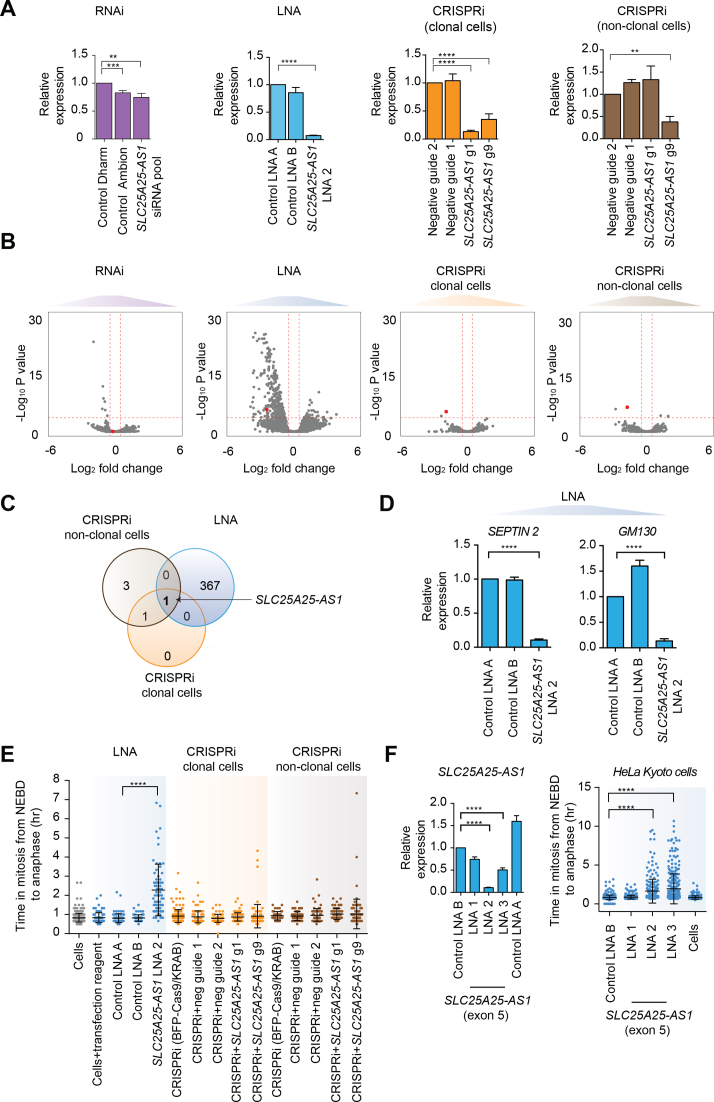
No overlap in DEGs between the different LOF methods upon depletion of SLC25A25-AS1. (A) Expression levels of SLC25A25-AS1 after RNAi, LNA and CRISPRi-mediated depletion. qPCR revealed only a 25% reduction in SLC25A25-AS1 transcription after siRNA-mediated knockdown relative to negative control siRNA from Dharmacon (Control Dharm), and no significant difference relative to negative control siRNA from Ambion (Control Ambion). LNA-mediated knockdown of SLC25A25-AS1 was performed using LNA oligonucleotide sequence 2 (LNA 2), and showed 90% reduction. CRISPRi-mediated repression of SLC25A25-AS1 using two guide RNAs targeting the TSS of SLC25A25-AS1 relative to the negative (non-targeting) guide RNA 2 yielded 70–90% knockdown in clonal cells. Only one guide RNA (guide 9) was efficient in depleting SLC25A25-AS1 in non-clonal cells. Statistical significance by two-tailed Student's t-test: **P< 0.01, ***P< 0.001 and ****P< 0.0001. For all graphs, expression levels of SLC25A25-AS1 were measured by qPCR using primers spanning exons 1–4, and normalized to the geometric mean of GAPDH and RPS18. Error bars, s.e.m. (n = 4 biological replicates). (B) Volcano plots of transcriptional differences induced by RNAi, LNA and CRISPRi-mediated depletion of SLC25A25-AS1. After siRNA-mediated depletion of SLC25A25-AS1, seven genes were differentially expressed compared to the negative control siRNAs. LNA-mediated depletion with LNA 2 identified 370 DEGs compared to negative control oligonucleotides. CRISPRi-mediated depletion of SLC25A25-AS1 using guide RNA 1 and 9 revealed only two DEGs compared to negative guide RNA 2. In non-clonal cells, only four DEGs were identified using guide RNA 9 compared to the negative guides. The red horizontal line represents the significance threshold corresponding to an FDR of 5%. Red vertical lines are log2-fold change thresholds of ±0.5. The red dot corresponds to the SLC25A25-AS1 itself. (C) Venn diagram showing no overlap between the sets of DEGs identified after using LNA and CRISPRi to deplete SLC25A25-AS1. The only gene in common between LNA and CRISPRi-mediated depletion is SLC25A25-AS1 itself. The total number of genes used for this analysis was 18224. (D) qPCR confirmation of the downregulation of two DEGs (SEPTIN2 and GM130) identified in B after LNA-mediated depletion of SLC25A25-AS1 with LNA 2. Expression levels were normalized to the geometric mean of GAPDH and RPS18. Error bars, s.e.m. (n = 3 biological replicates). Statistical significance by two-tailed Student's t-test: ****P< 0.0001. (E) Quantification results from time-lapse microscopy of mitotic progression of HeLa cells incubated with Sir-Hoechst after LNA and CRISPRi-mediated (clonal and non-clonal) depletion of SLC25A25-AS1. Mitotic duration was measured from nuclear envelope breakdown (NEBD) to anaphase onset. Bars show mean±s.d. (n = 2 independent biological replicates). Statistical significance by Mann–Whitney test: ****P< 0.0001. (F) Left panel: Expression analysis of SLC25A25-AS1 by qPCR using two additional LNAs targeting SLC25A25-AS1 (LNA 1 and LNA 3). Expression levels were normalized to the geometric mean of GAPDH and RPS18. Error bars, s.e.m. (n = 3 biological replicates). Statistical significance by two-tailed Student's t-test: ****P< 0.0001. Right panel: Quantification results from time-lapse microscopy using HeLa Kyoto cells after depletion of SLC25A25-AS1 using three different LNAs. Bars show mean±s.d. (n = 2 biological replicates). Statistical significance by Mann–Whitney test: ****P< 0.0001. The list of DEGs identified after RNAi, LNA and CRISPRi-mediated depletion of SLC25A25-AS1 are shown in Supplementary Table S2.